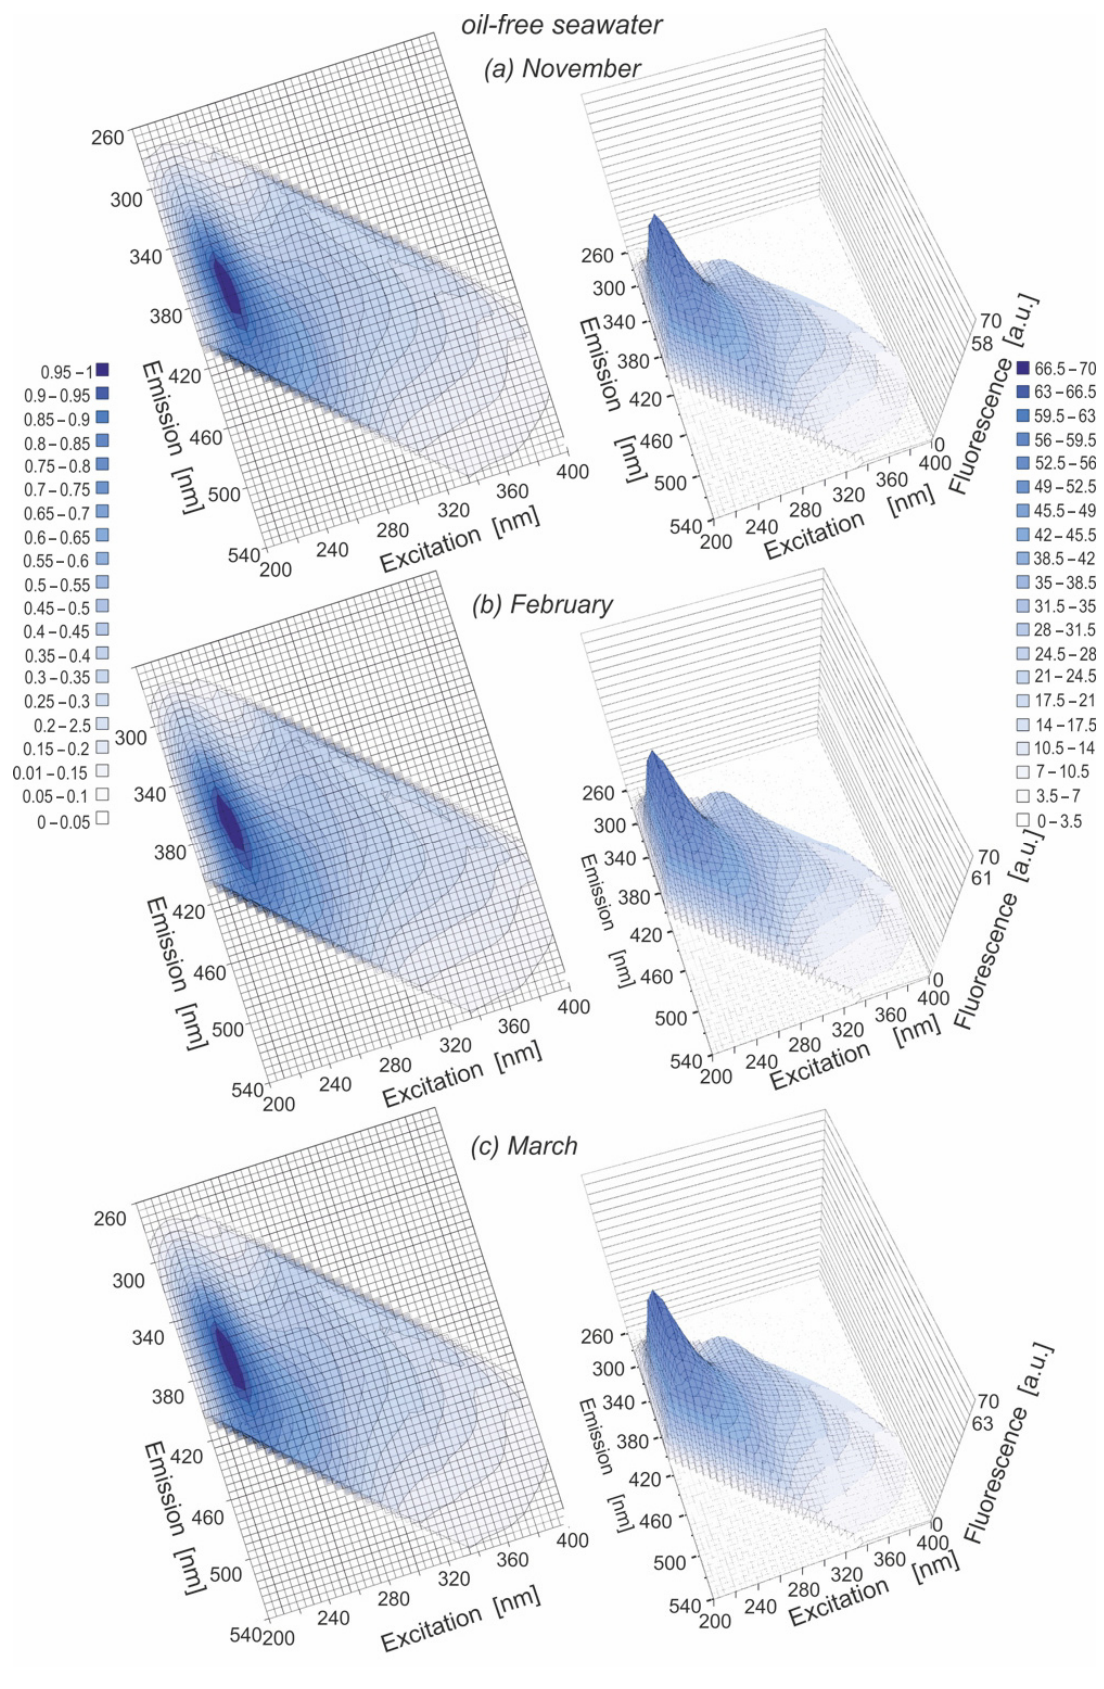
Figure 3. EEMs of oil-free seawater in 2D ( left side) and 3D ( right side) for various months: November ( a ), February ( b ) and March ( c ).